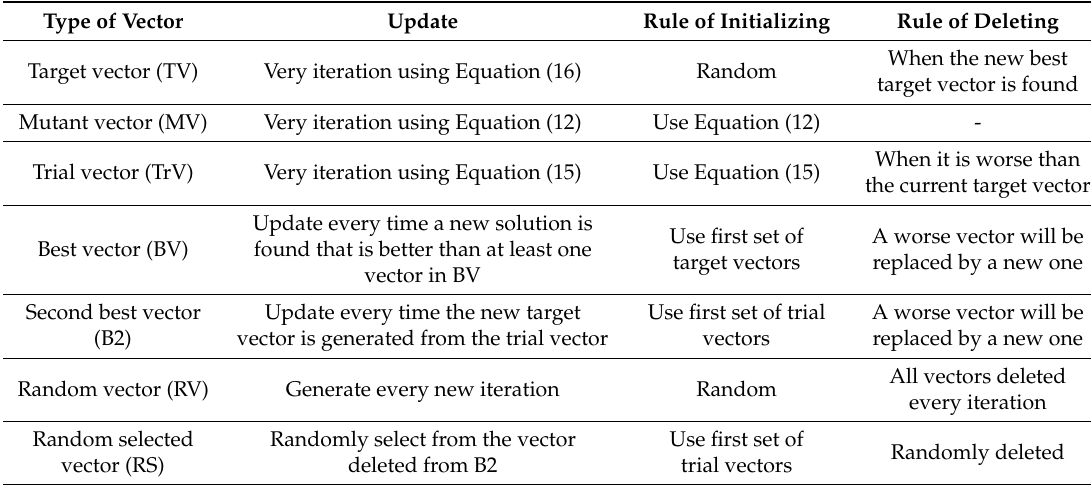
Table 9. Conclusion of types of vector